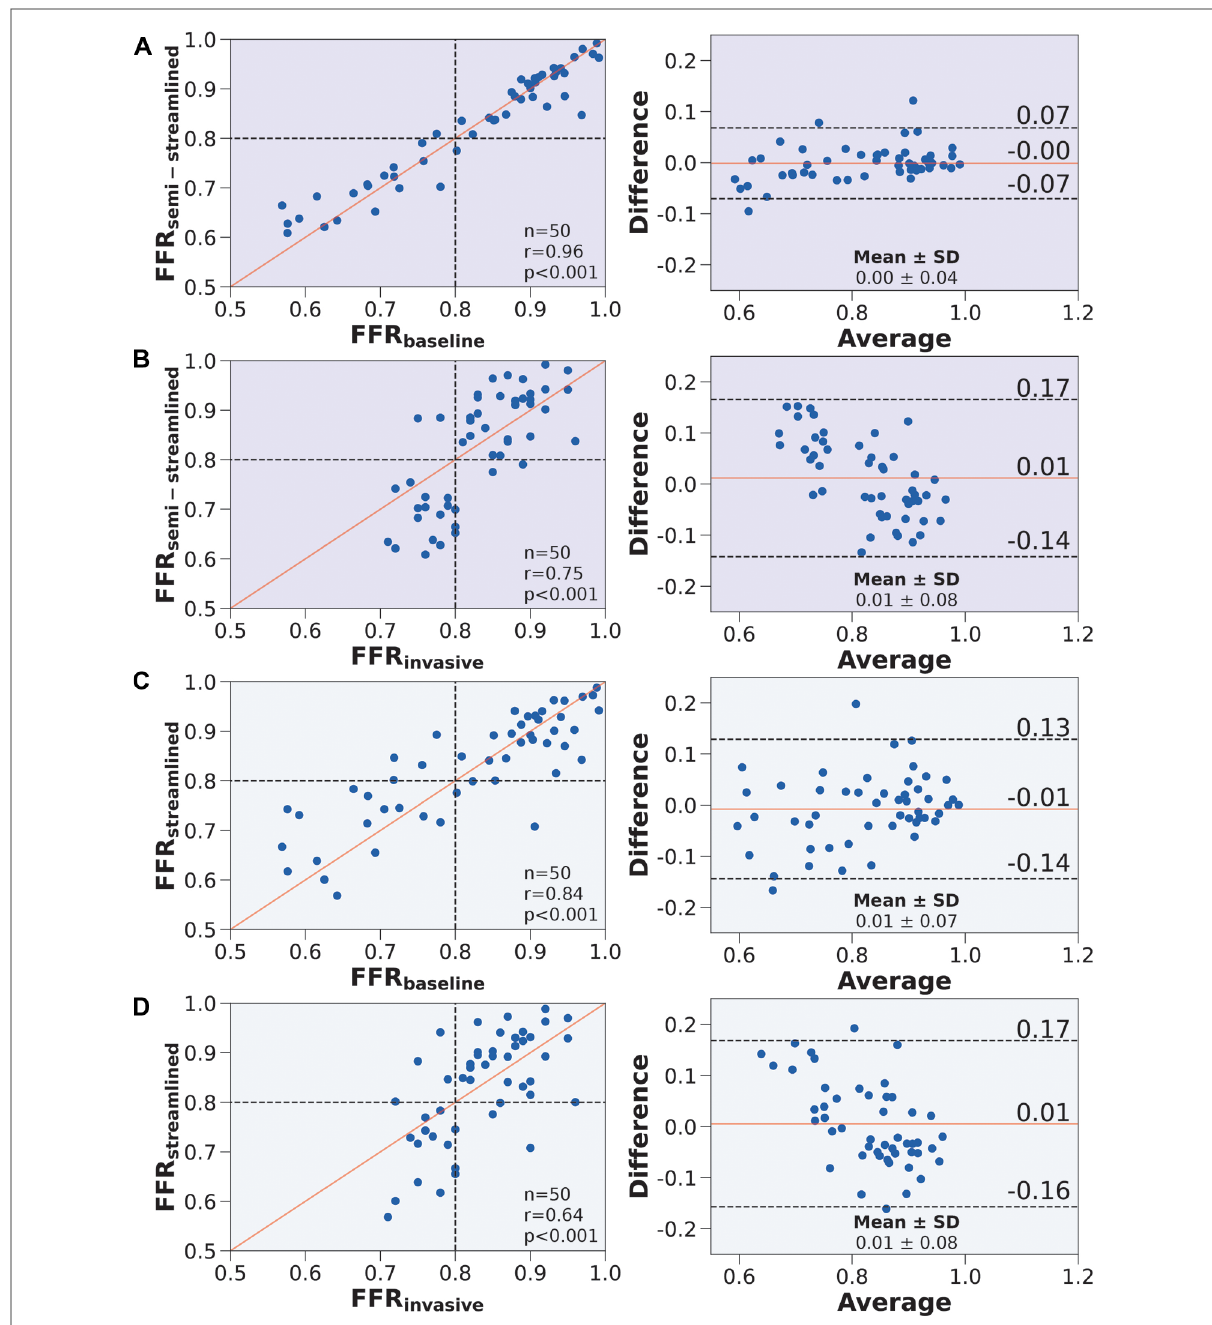
FIGURE 5 Correlation and agreement comparing FFR semi (cid:1) streamlined , FFR streamlined , FFR baseline , and FFR invasive . (Left) Scatter plots. The number of stenoses and Pearson ’ s r are presented in the lower right hand corner. Interrupted lines represent the 0.80 ischemic threshold and the solid red line represents ideal correlation. (Right) Bland-Altman plots. The mean difference and standard deviation are presented in the lower right corner. Black interrupted lines indicate the upper and lower limits of agreement ( s : + 1.96) and the solid red line indicates mean difference. We compared ( A ) FFR semi (cid:1) streamlined to FFR baseline , ( B ) FFR semi (cid:1) streamlined to FFR invasive , ( C ) FFR streamlined to FFR baseline , and ( D ) FFR streamlined to FFR invasive